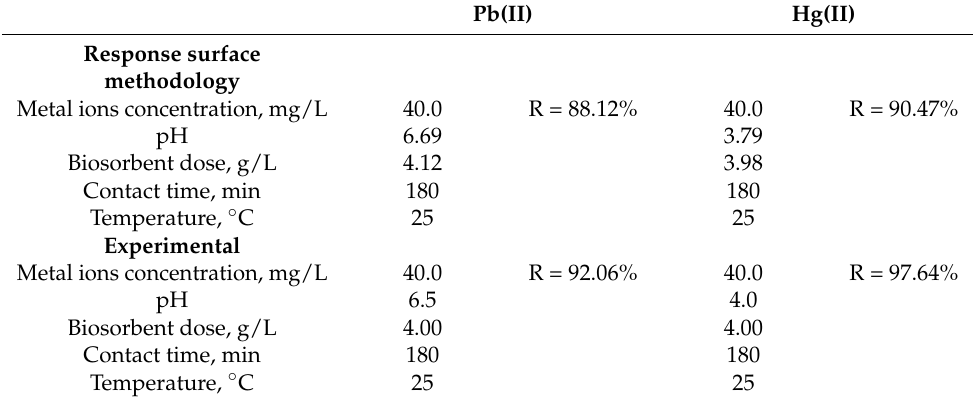
Table 2. Optimal conditions for the biosorption of Pb(II) and Hg(II) ions onto